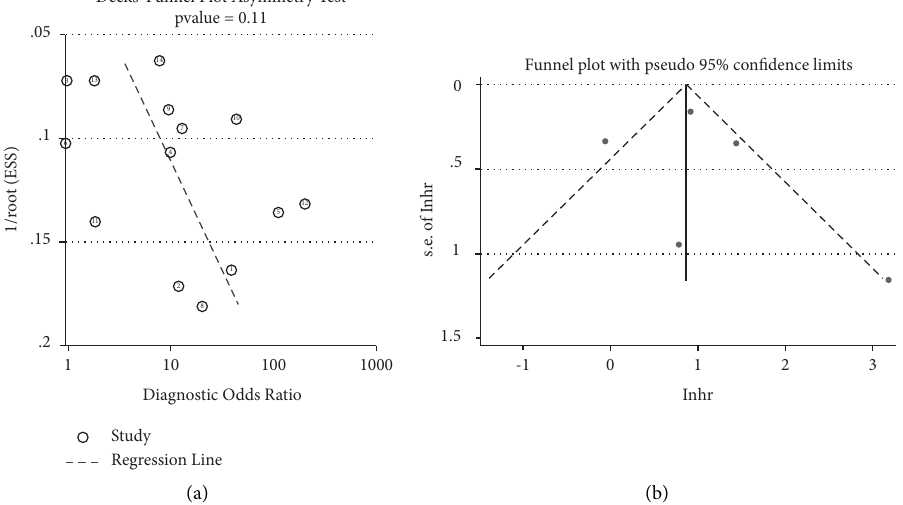
Figure 5: Te assessment of potential publication bias in the meta-analysis. (a) Deeks’ test for the diagnostic meta-analysis. (b) Begg’s test for the overall survival